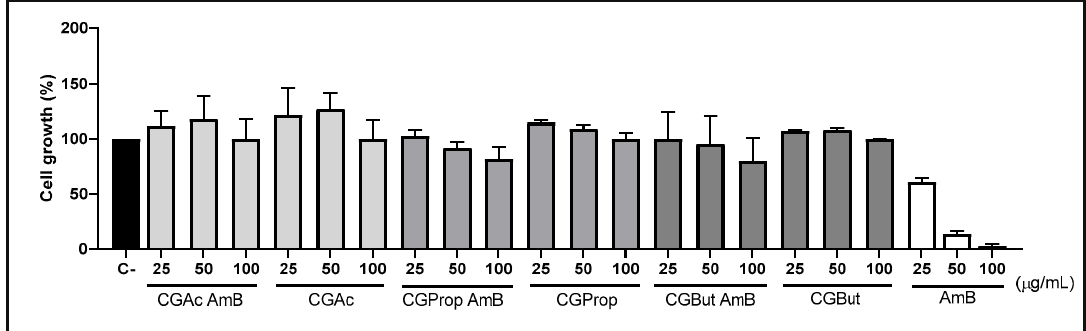
Figure 8. Evaluation of in vitro cell growth of CGAc AmB, CGProp AmB and GCBut AmB (loaded vectors), CGAc, CGProp and CGBut (unloaded vectors), and Amphotericin B (AmB) after 72 h of treatment, at concentrations of 25, 50, and 100 µ g/mL. IC 50 of Amphotericin B (positive control): 26.6 µ g/mL. C-: negative